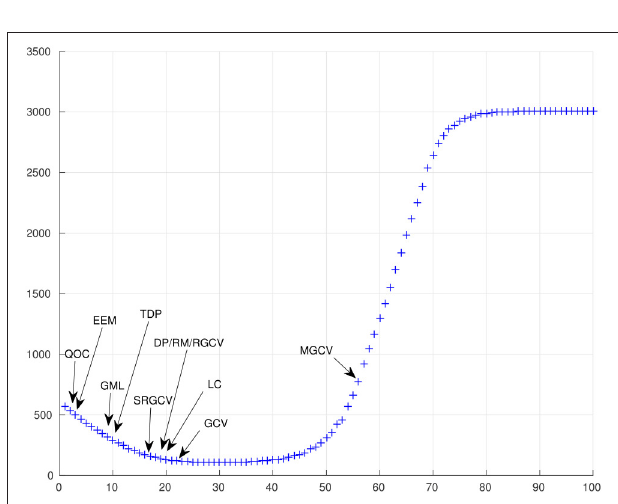
FIGURE 17 | The horizontal axis states the index k of the regularization parameter and the vertical axis shows